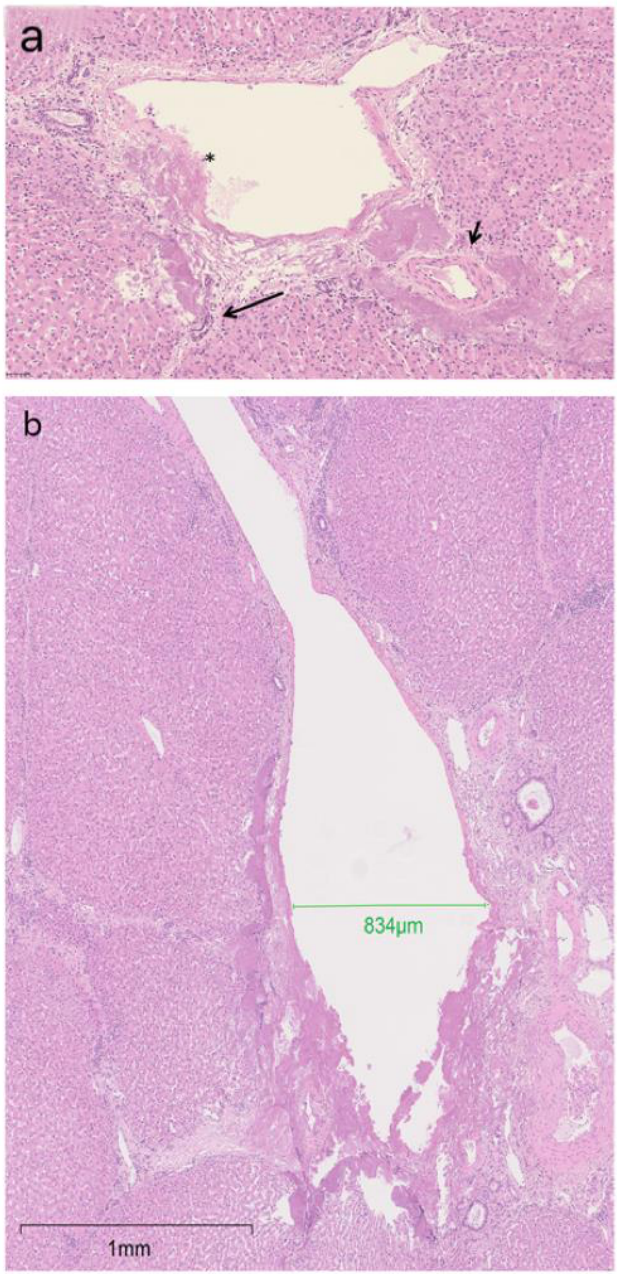
Figure 5. ( a ) BH lesion extending to a nearby portal tract with injury to portal vein (asterisk), bile duct (long arrow), and encasement of an arterial branch (short arrow) (H&E). ( b ) Injury to a portal vein that is 834 µ m in diameter (green